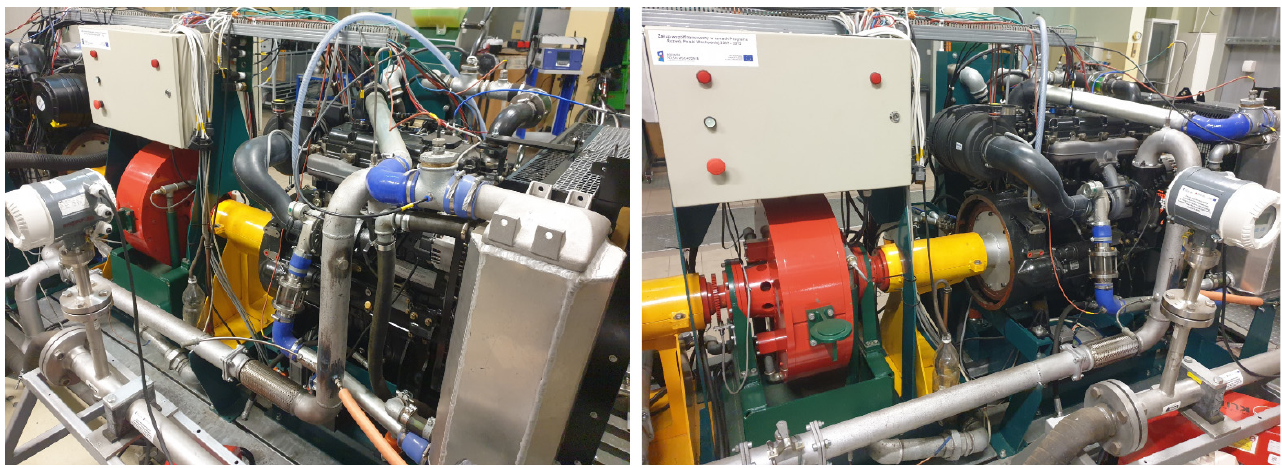
Figure 1. Braking stand with Perkins 1104D-44TA engine.